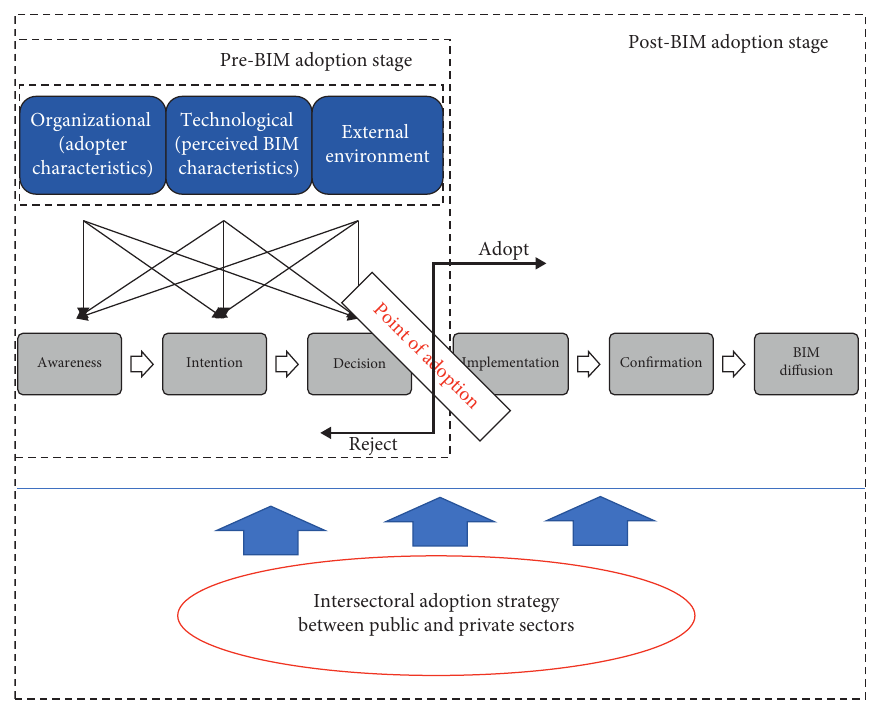
Figure 3: Conceptual IDT BIM adoption process (adopted from [10, 23]).